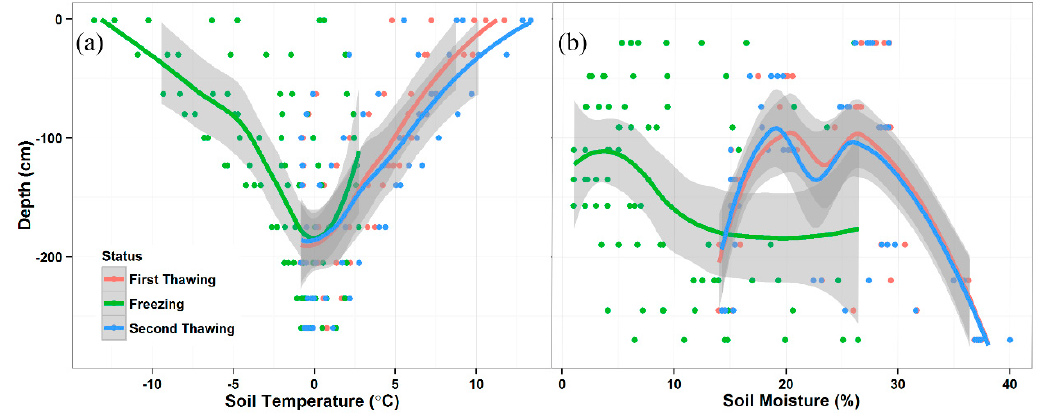
Figure 11. Monthly mean soil temperature and moisture contents in different layers during the two thawing periods and one freezing period: ( a ) Soil temperature (°C); and ( b ) soil moisture (%). The colored lines are the non-linear average values.